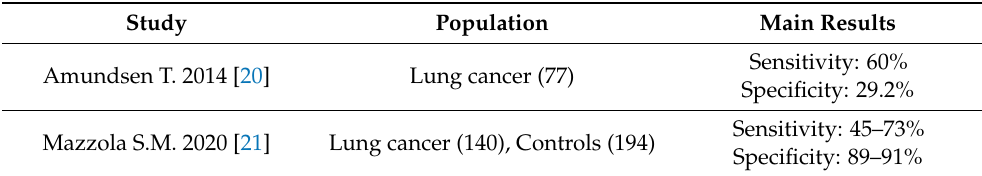
Table 1. Studies using sniffer dog detection of urinary VOCs.